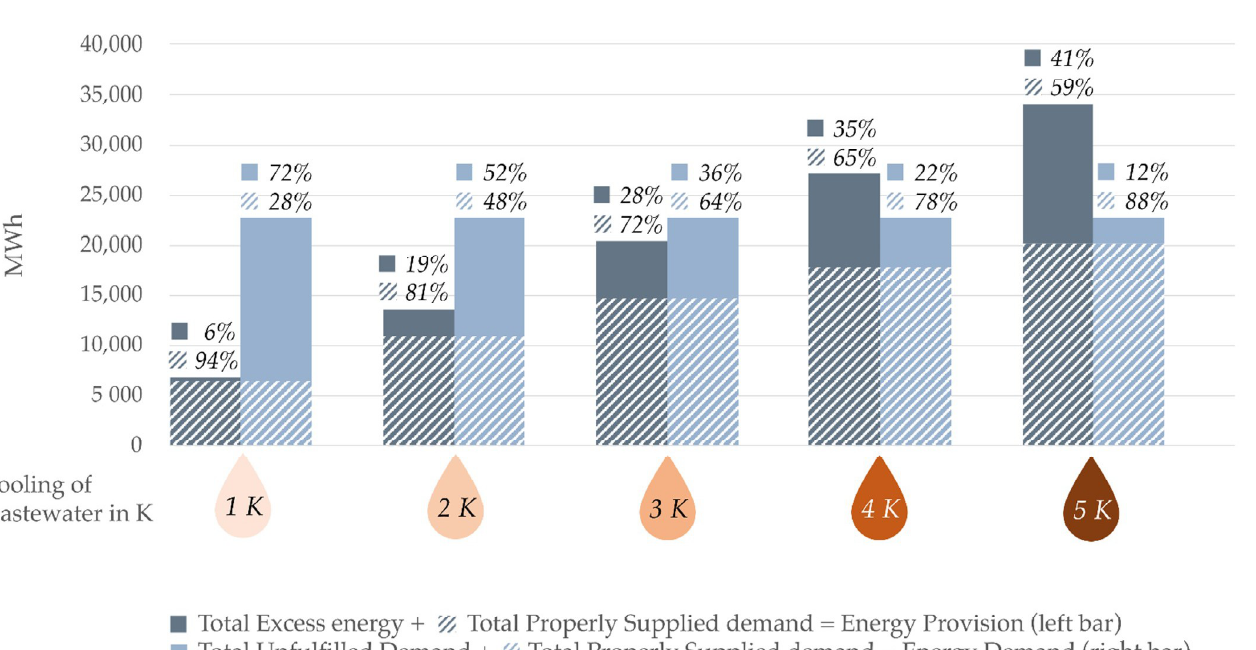
Figure 9. Spatiotemporal results of heat demand in the energy zones and heat recovery from the WWTP (own